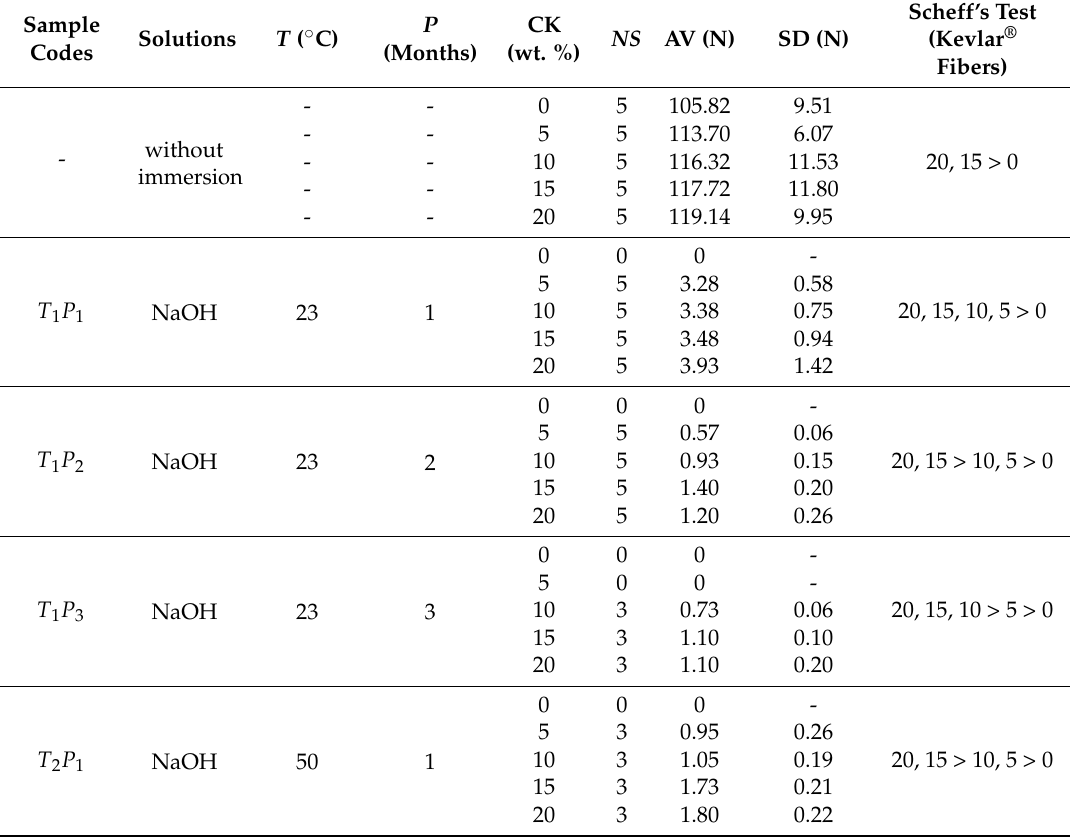
Table 2. Tensile strength and statistical analyses of recycled Kevlar ® /PET/LPET nonwoven geotextiles that are immersed in NaOH, in relation to different immersion